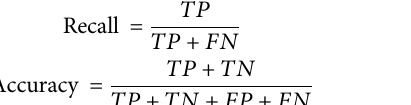
Frontiers in Cell and Developmental Biology |